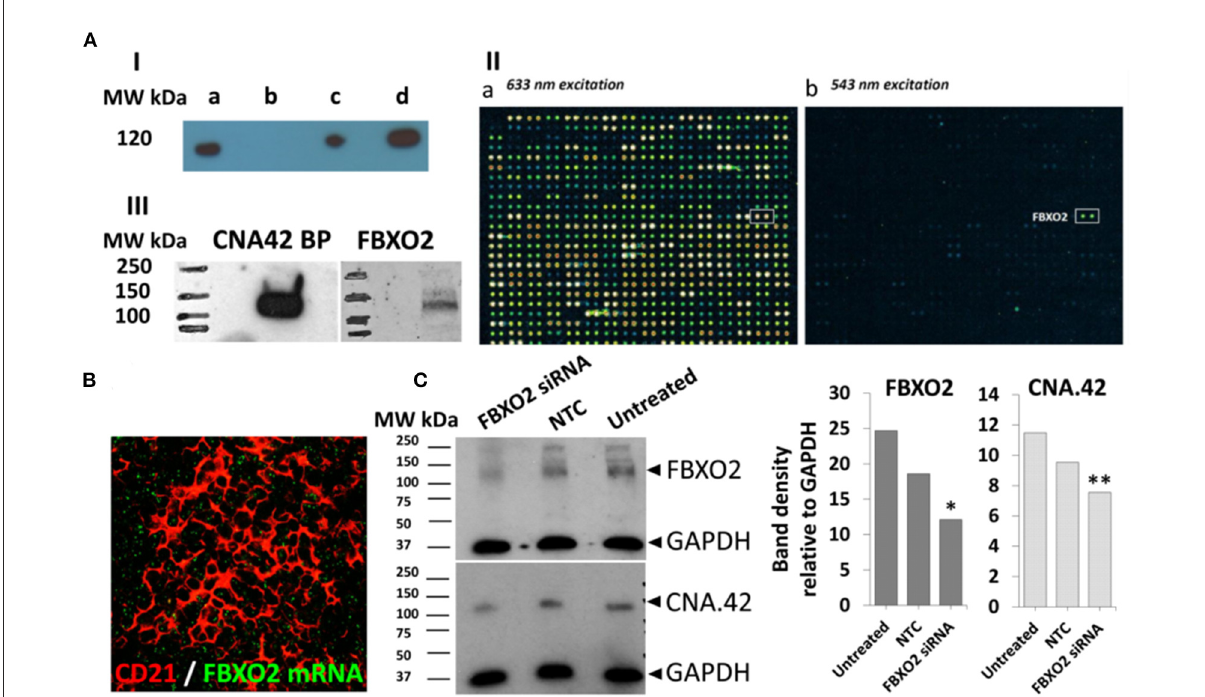
FIGURE9 The FDC mAb CNA.42 recognizes FBXO2. (A) Immunoprecipitation (IP) and characterization of the CNA-42 binding protein. (A-I) Western blotting of total cell lysate (a), negative control (agarose beads only) and the CNA.42-immunoprecipitated proteins (c and d, 1.5 and 6 uls/lane respectively) from tonsillar single cell suspension probed with CNA-42. A single band is detectable at 120 Kd. (A-II) the reactivity of the CNA.42 mAb on the HuProt TM human proteome microarray showing subarray 9-1 of array 1300017931 (used for the CNA.42) with fluorescence detection at 633nm excitation (a) and 543nm excitation (b). (a) Staining with biotinylated anti-GST and Streptavidin-647. Rows 1-28 show generic staining of the GST-tagged immobilized human proteins, among them FBXO2 in row 11. (b) Probing with CNA.42 and Cy3 labeled anti-mouse IgM shows one hit, the human protein FBXO2 in the subarray. (A-III) Western blotting of tonsillar lysates with FBXO2 and CNA-42-specific antibodies recognize 120 Kd bands in the lysates [CNA.42 BP = CNA.42 binding protein]. (B) In situ hybridization of FBXO2 mRNA (green) showing intracellular signal in tonsillar CD21 + FDC reticula (red). (C) Western blotting of lysates from the CAN.42 expressing CEM cell line using mAb CAN.42 and anti FBXO2. CEM were untreated or treated either with Accell human FBXO2 siRNA (1 uM), or non-targeting control (NTC). GAPDH is used as a loading control. Compared to untreated cells, densitometric analysis with Image J indicates that FBXO2 siRNA-treated cells expressed 50% (*) and 35% (**) less FBXO2 and CNA.42,